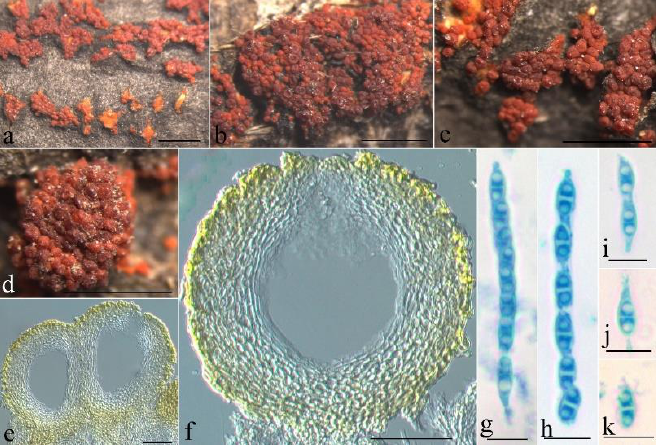
Figure 6. Macroscopic and microscopic morphology of Pseudocosmospora beijingensis (HMAS 290896). ( a – d ) Ascomata on natural substratum; ( e , f ) median section of perithecia in lactic acid; ( g , h ) asci with ascospores in lactophenol cotton blue; ( i – k ) ascospore in lactophenol cotton blue. Bars: ( a – d ) = 1 mm; ( e , f ) = 50 µ m; ( g – k ) = 10 µ m.